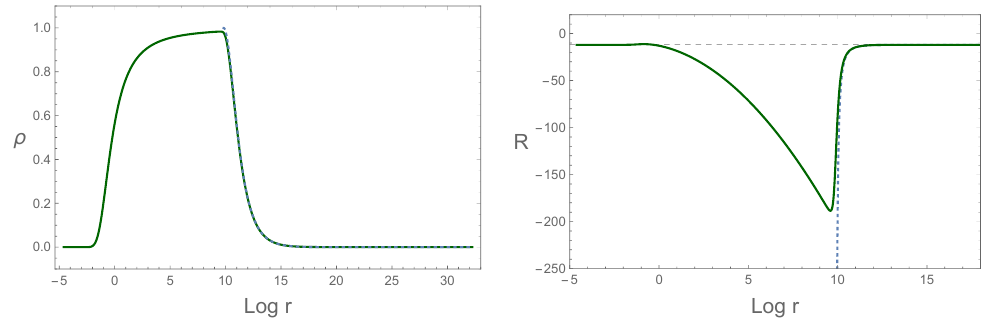
Figure 3 . The scalar pro(cid:12)le, (cid:26) , and Ricci curvature scalar, R , for a non-perturbative anisotropic boomerang (cid:13)ow with (cid:3) =k (cid:25) 34 : 2. The light blue dotted line shows the dielectric (cid:13)ow solution whose leading fall-o(cid:11) matches that of the full boomerang (cid:13)ow. The dashed black line shows the unit radius AdS 4